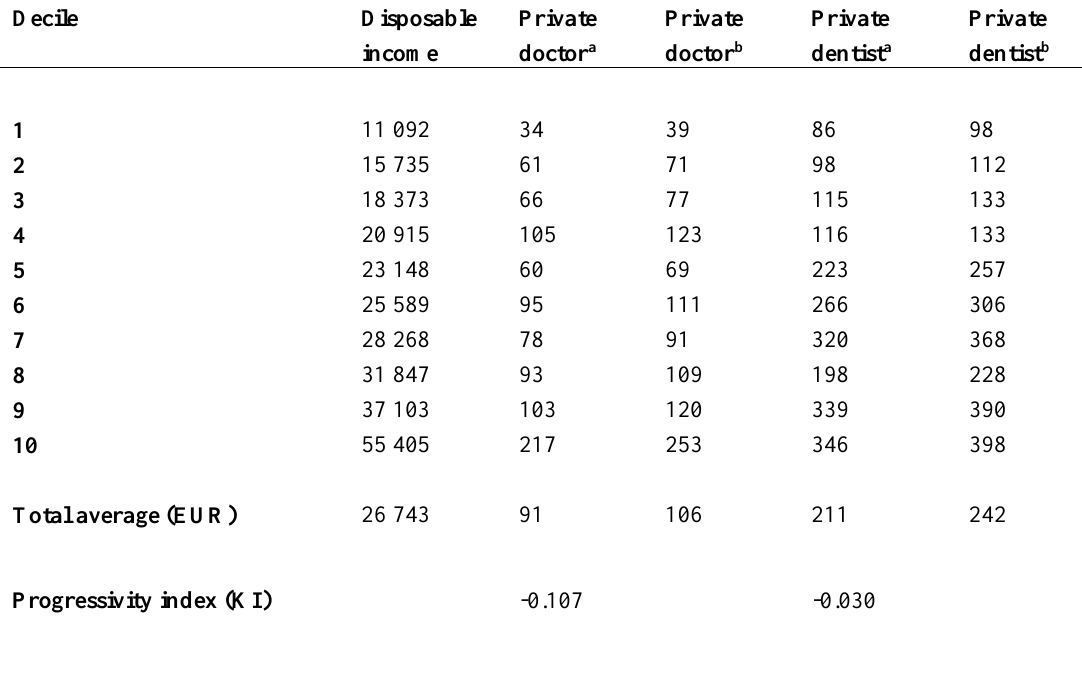
Private health services fees before and after the reform by deciles (EUR) Decile Disposable